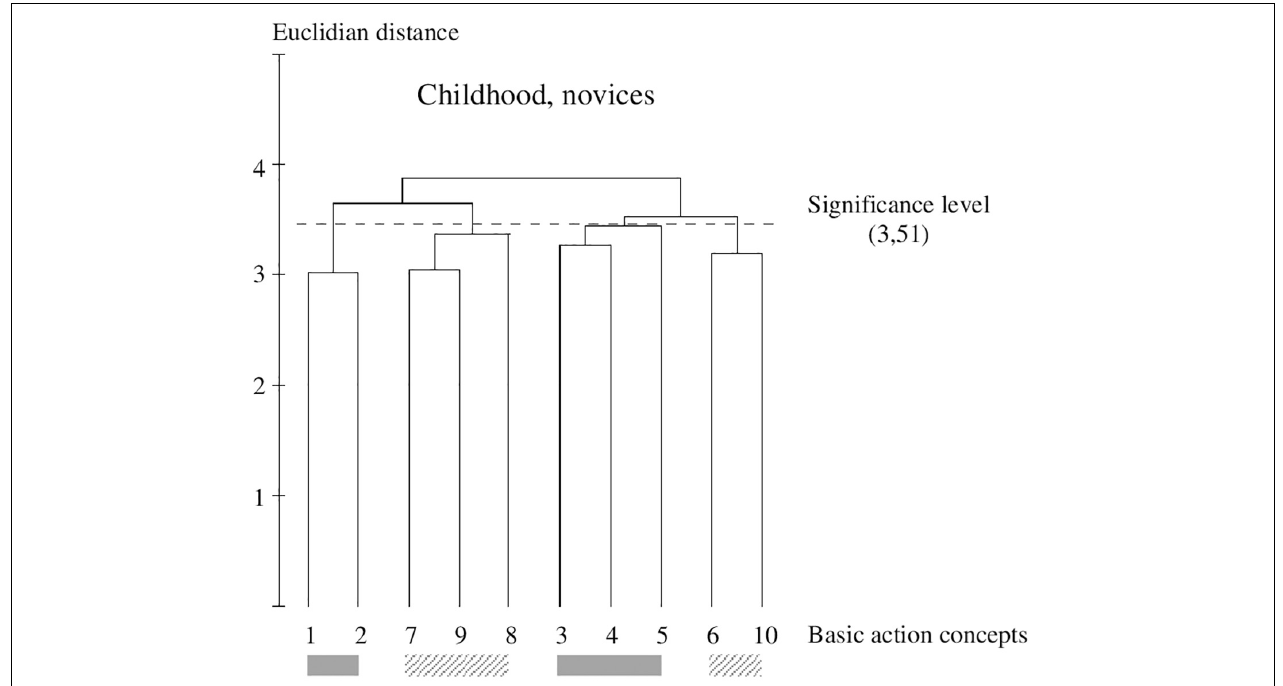
FIGURE 2 | Outcome of the hierarchical cluster analysis of novices within childhood ( N = 75) displayed as a dendrogram. The dashed line clarifies the critical value of d crit = 3.51, which corresponds to a significance level of 5%. The BACs are marked with numbers among the dendrogram and highlighted with the gray solid bar (technically correct BAC) and diagonally striped bar (faulty BAC).